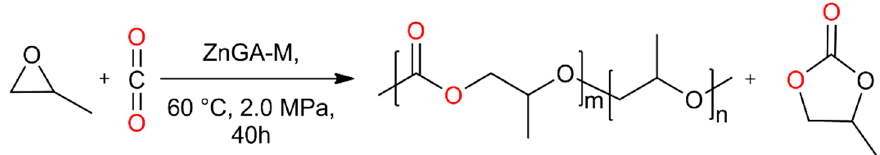
Scheme 1. Copolymerization of CO 2 and PO using ZnGA-M.